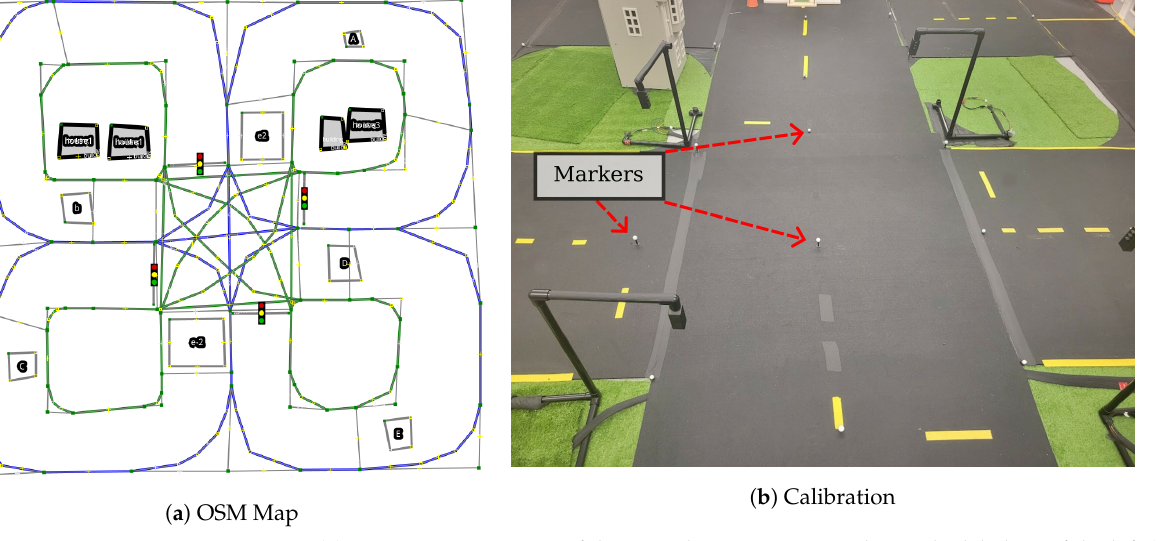
Figure 4. ( a ) OpenStreetMap map of the a single intersection with Lanelet labeling of the left (blue) and right boundaries (green). ( b ) Optitrack markers placed on roads give high quality ground truth position for map. The MiniCity map is used in autonomous navigating of the MiniCity and for evaluating downstream tasks such as traffic violations due to poor localization.